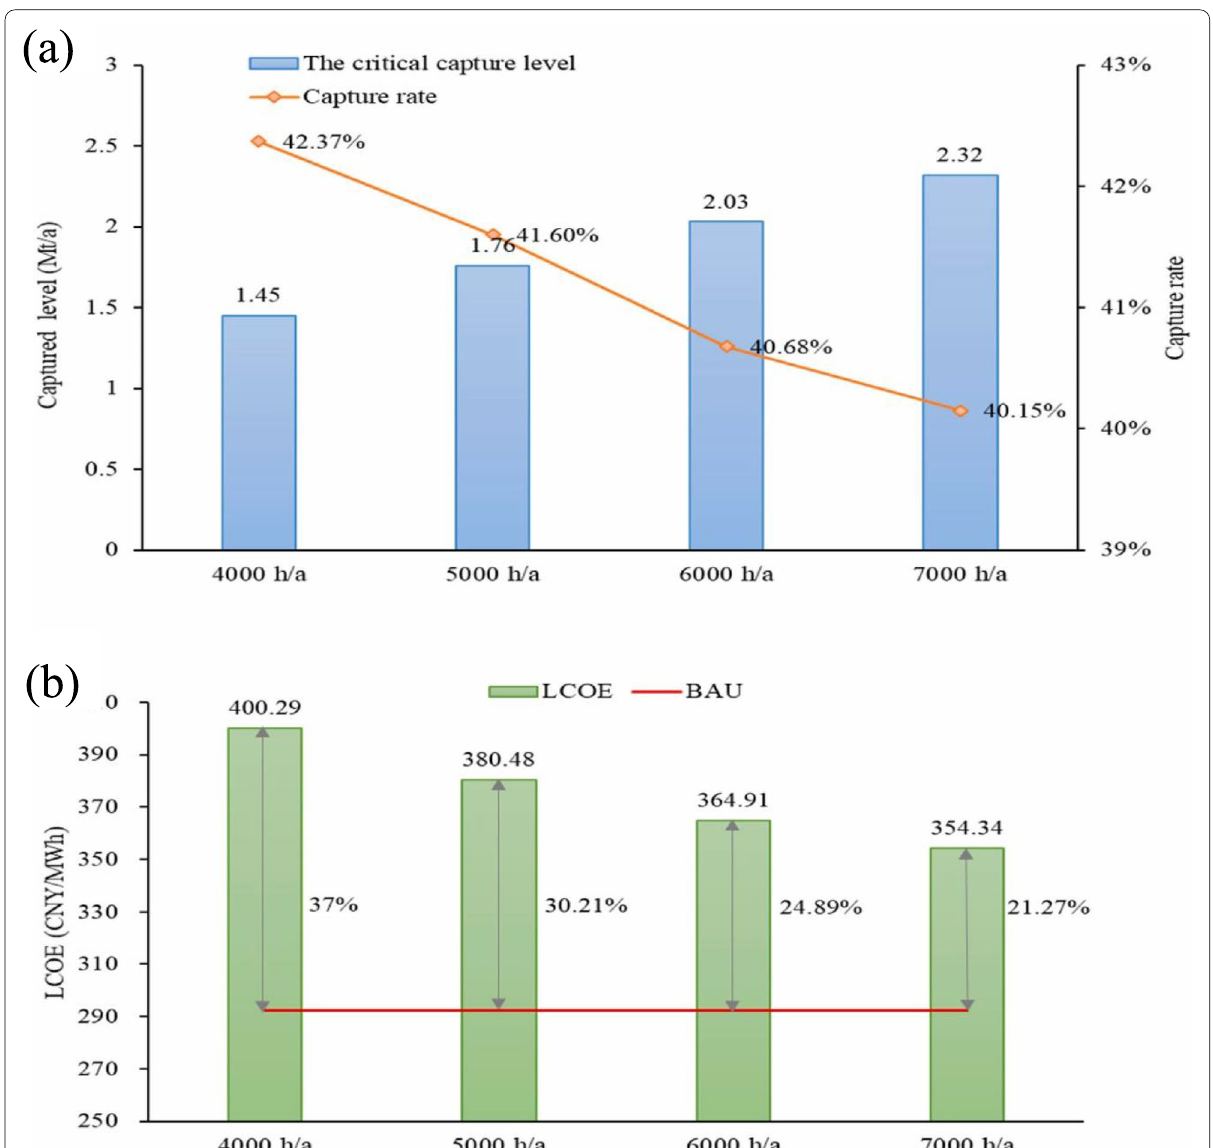
Fig. 6 Critical conditions for emission levels of CFPP retrofitted with CCS ( a ) and gas-fired generators ( b ) with the same power quota(COCE: levelized cost of electricity; BAU: business-as-usual)